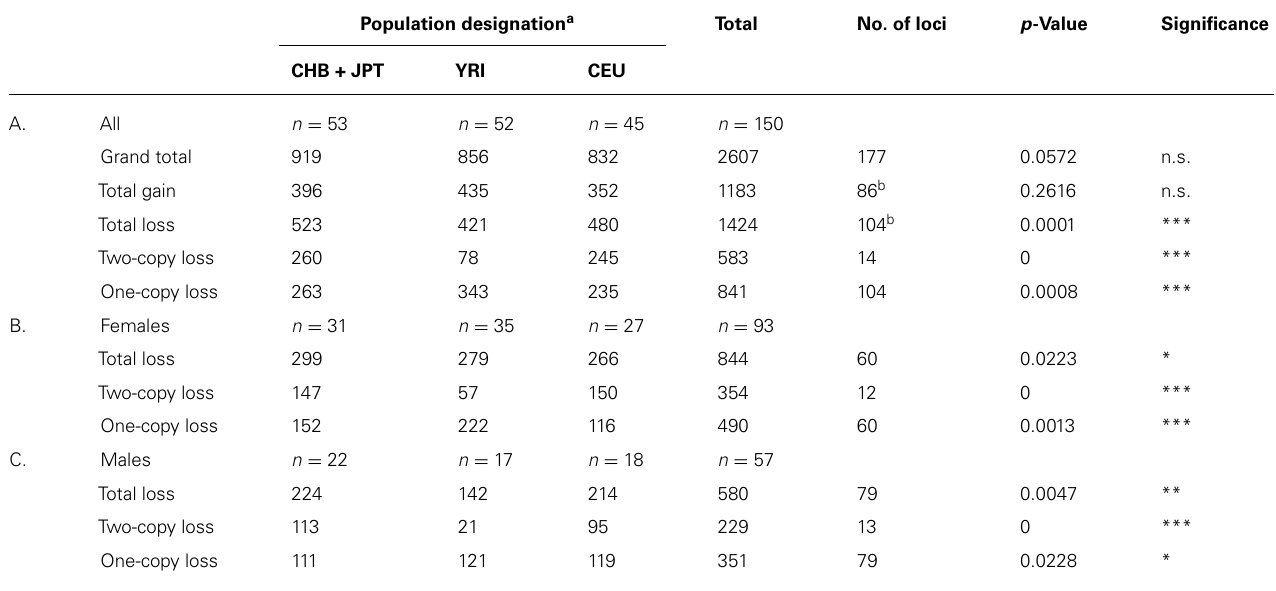
Table 4 | Gender comparisons of the CNV numbers among OR pseudogenes for one and two-copy number loss between three diverse populations.